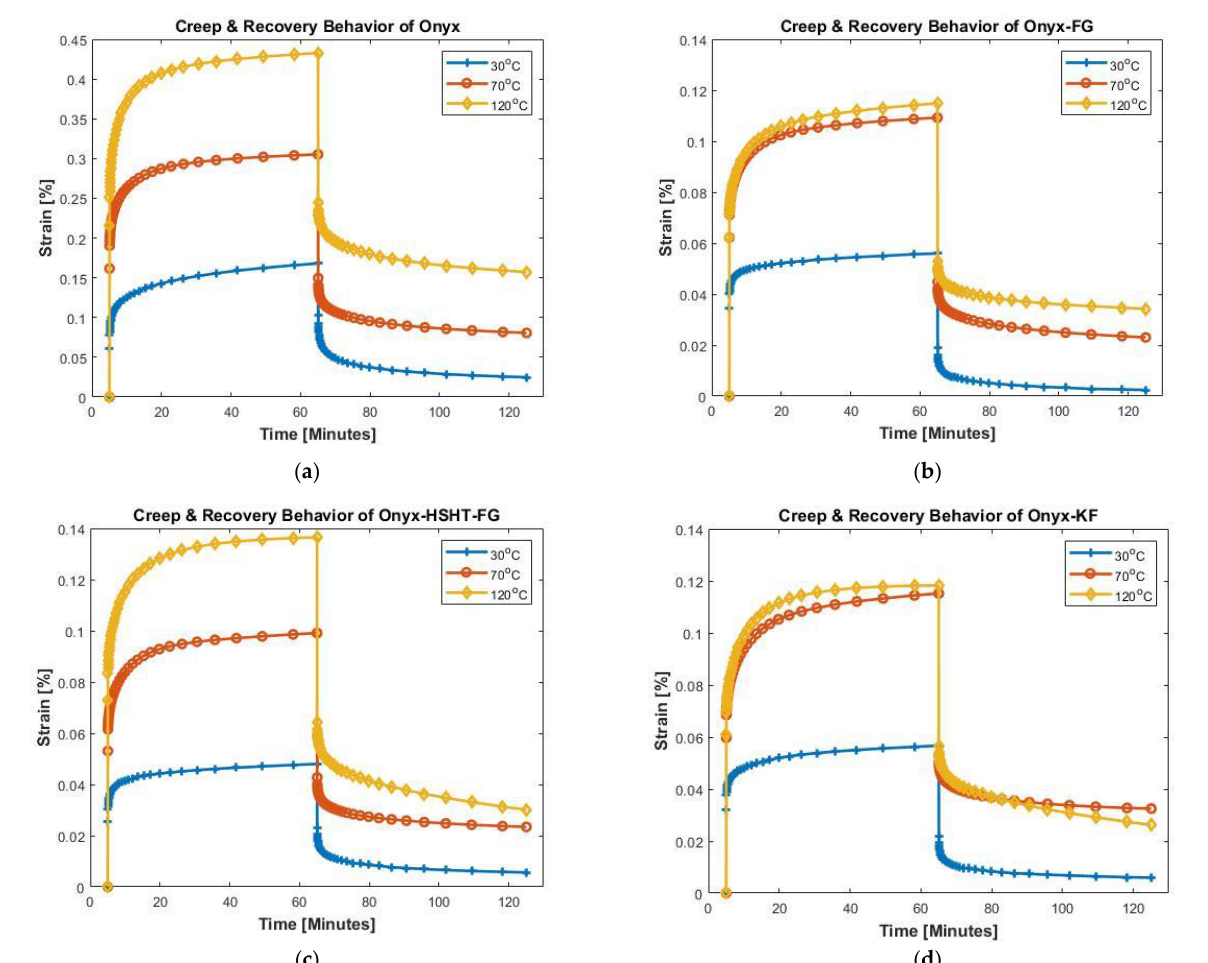
Figure 3. Creep and recovery curves of CFR3DP composites; ( a ) Creep and recovery behavior of Onyx; ( b ) Creep and recovery behavior of Onyx-FG; ( c ) Creep and recovery behavior of Onyx-HSHT-FG; ( d ) Creep and recovery behavior of Onyx-KF.